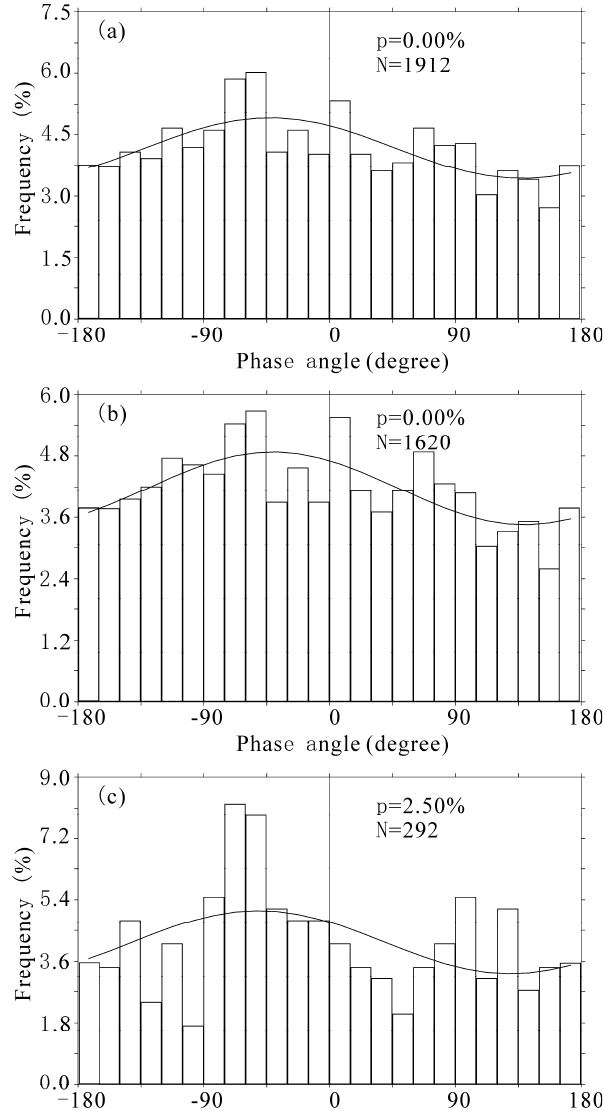
Figure 4. Frequency distributions of the tidal phase angles for the three subsets with 0 < depth < 30 km and different cutoff magnitudes: ( a ) any M; ( b ) 0 < M < 5; ( c ) M ≥ 5.